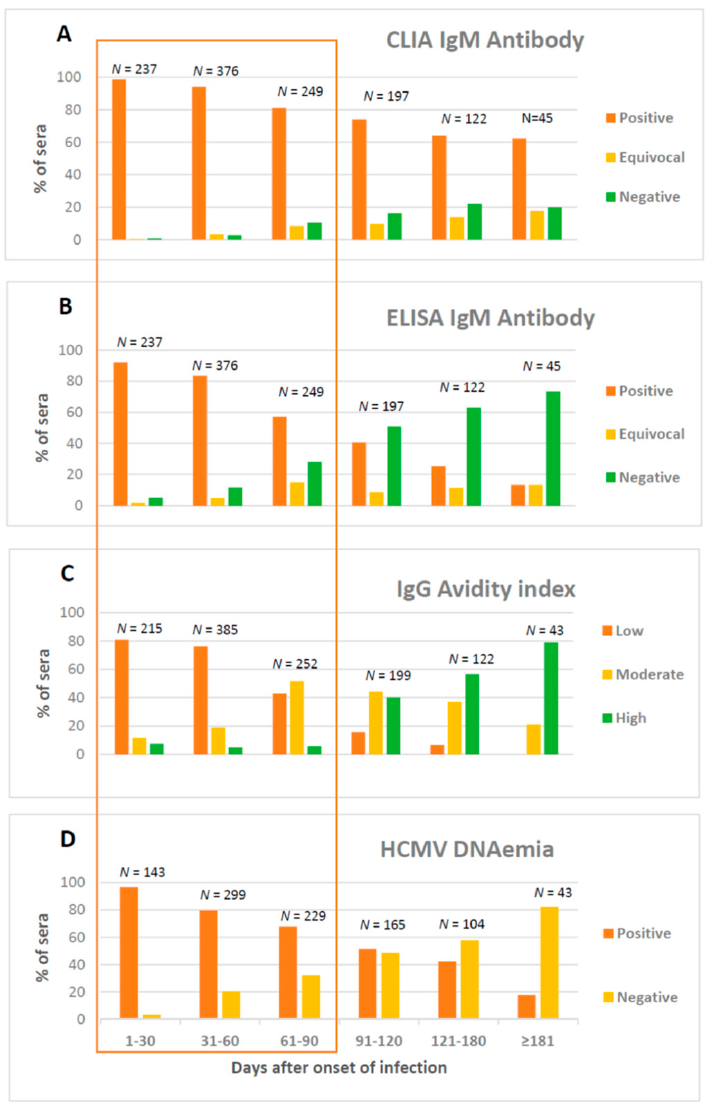
Figure 1. ( A ) HCMV chemiluminescent immunoassay (CLIA) for IgM antibody; ( B ) enzyme-linked immunosorbent assay (ELISA) for IgM antibody; ( C ) IgG avidity index; and ( D ) DNAemia. Re- sults as obtained on sequential serum and whole blood samples from 465 pregnant women with HCMV PI